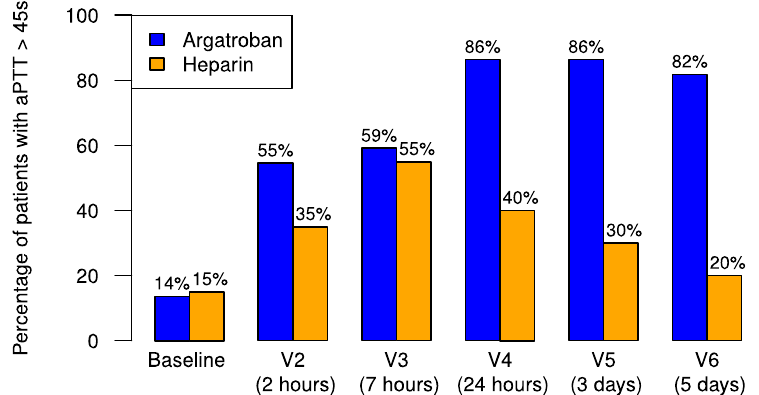
Figure 2. Achievement of the target activated partial thromboplastin time (aPTT) of more than 45 s. Patients who achieved the targeted aPTT of more than 45 s under heparin treatment (orange bars) and argatroban treatment (blue bars) in the intention-to-treat (ITT) groups. V indicates the study visits at pre-defined time points.